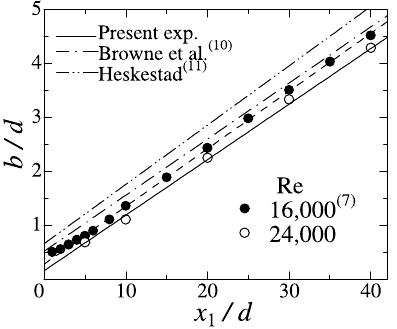
Fig. 11 Downstream variation of half width